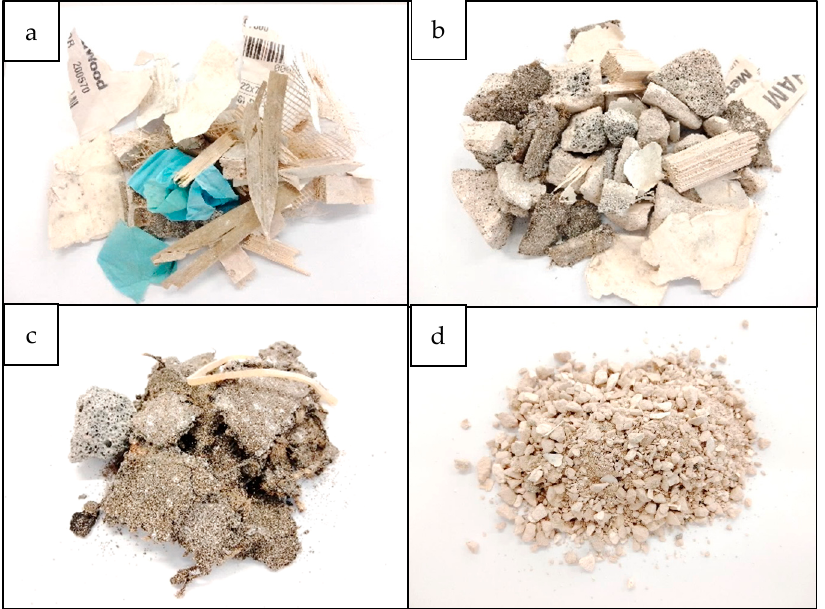
Figure 8. Contaminants in output 1 ( a ), contaminants in output 2 ( b ), unclassified material of output 3 ( c ), and unprocessed refurbishment plasterboard waste particles <10 mm in size ( d ).